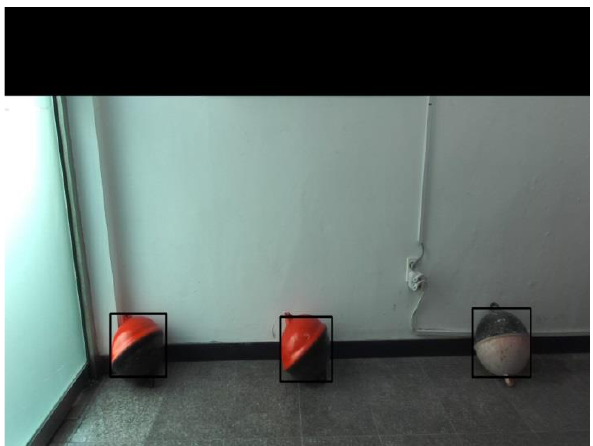
Figure 13. Summary of the experimental processing steps.